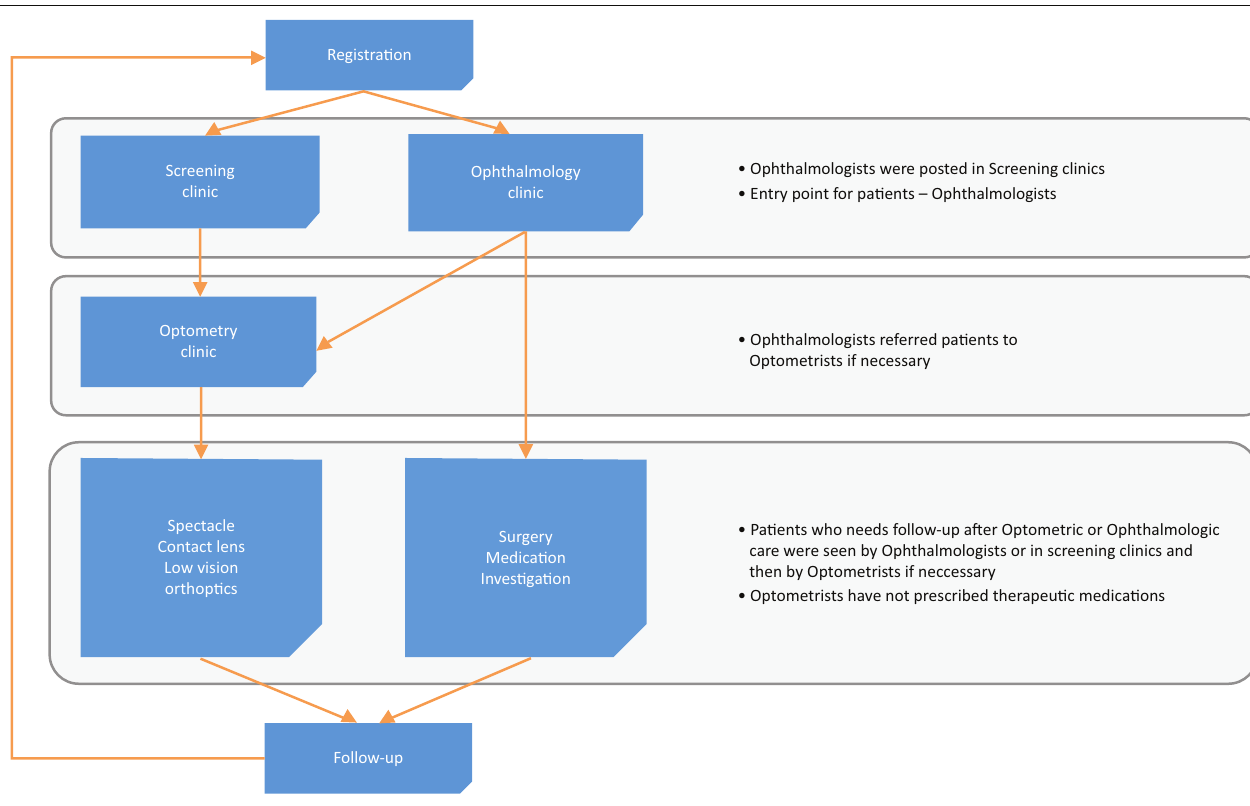
FIGURE 1: The current patient flow pattern in public eye clinics in Saudi